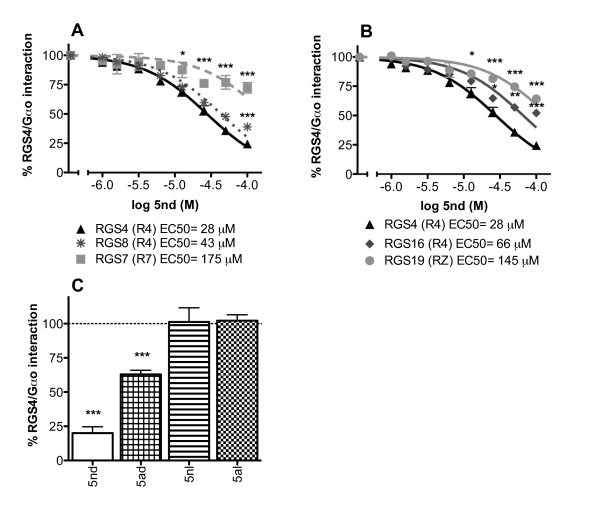
Characterization of hit 5. A) and B) Dose response curves for 5nd in the FCPIA with different RGS proteins (RGS Family), (mean ± S.E.M., n = 3) *p < 0.05, **p < 0.01, ***p < 0.001 compared to RGS4 at the same 5nd concentration. C) Peptides were tested at 50 μM as in Figure 1, (mean ± S.E.M., n ≥ 3) *p < 0.05, **p < 0.01, ***p < 0.001 compared to no peptide.